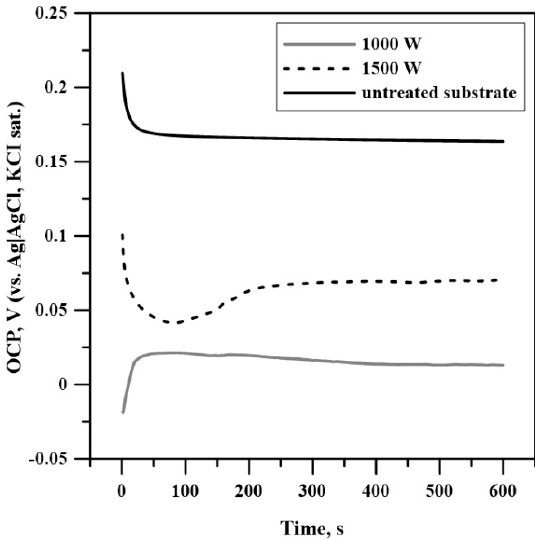
Figure 6. Corrosion potential of DLC-coated steel in 0.9% KCl solution as a function of time for reaching equilibrium; electrolyte: phosphate buffered saline, pH = 7.4 containing 0.9% KCl.